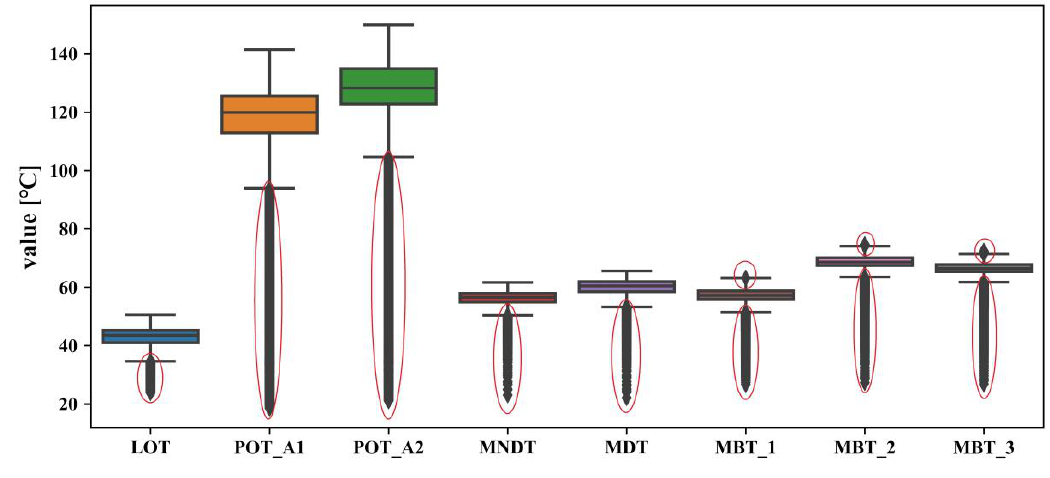
Figure 7. Data cleaning by boxplot.